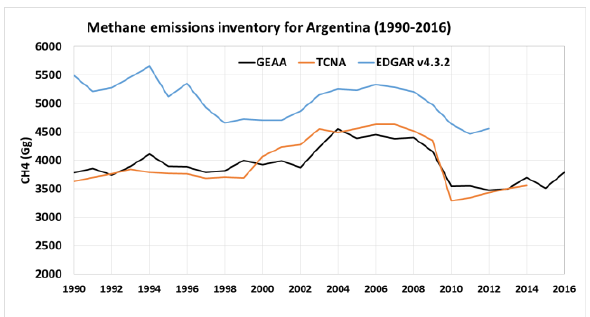
Figure 2. Comparison of methane emissions for